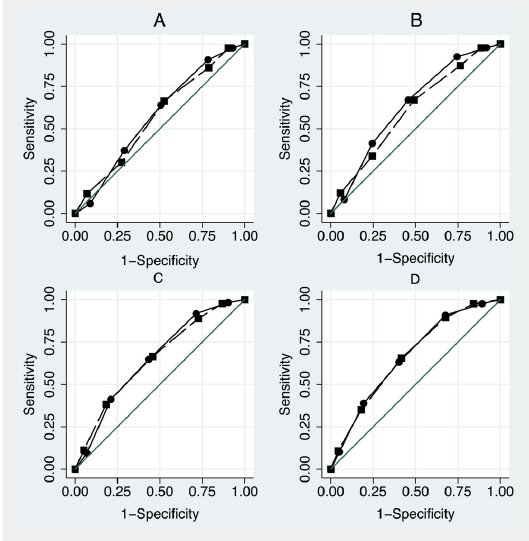
ROC curves of the Identification of Senior at Risk (ISAR – plain circle line) and the Triage Risk Stratification Tool (TRST- long-dash square-line) for readmission at 1, 3, 6 and 12 months. A: 1 month ISAR ROC area = 0.612 - TRST ROC area = 0.607 B: 3 months ISAR ROC area = 0.655 - TRST ROC area = 0.621 C: 6 months ISAR ROC area = 0.660 - TRST ROC area = 0.651 D: 12 months ISAR ROC area = 0.664 - TRST ROC area =